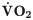
Relationships of work rate with V˙O2 (A), respiratory rate (B), tidal volume (C), minute ventilation (D), heart rate (E), stroke volume (F), cardiac output (G), and arterial-venous oxygen difference (H) during the exercise test. Diamonds, circles, and squares represent the mean values at rest, first threshold, and peak exercise, respectively. Vertical and horizontal bars represent standard deviation. The data of second threshold were excluded, as it was obtained from only 11 participants.